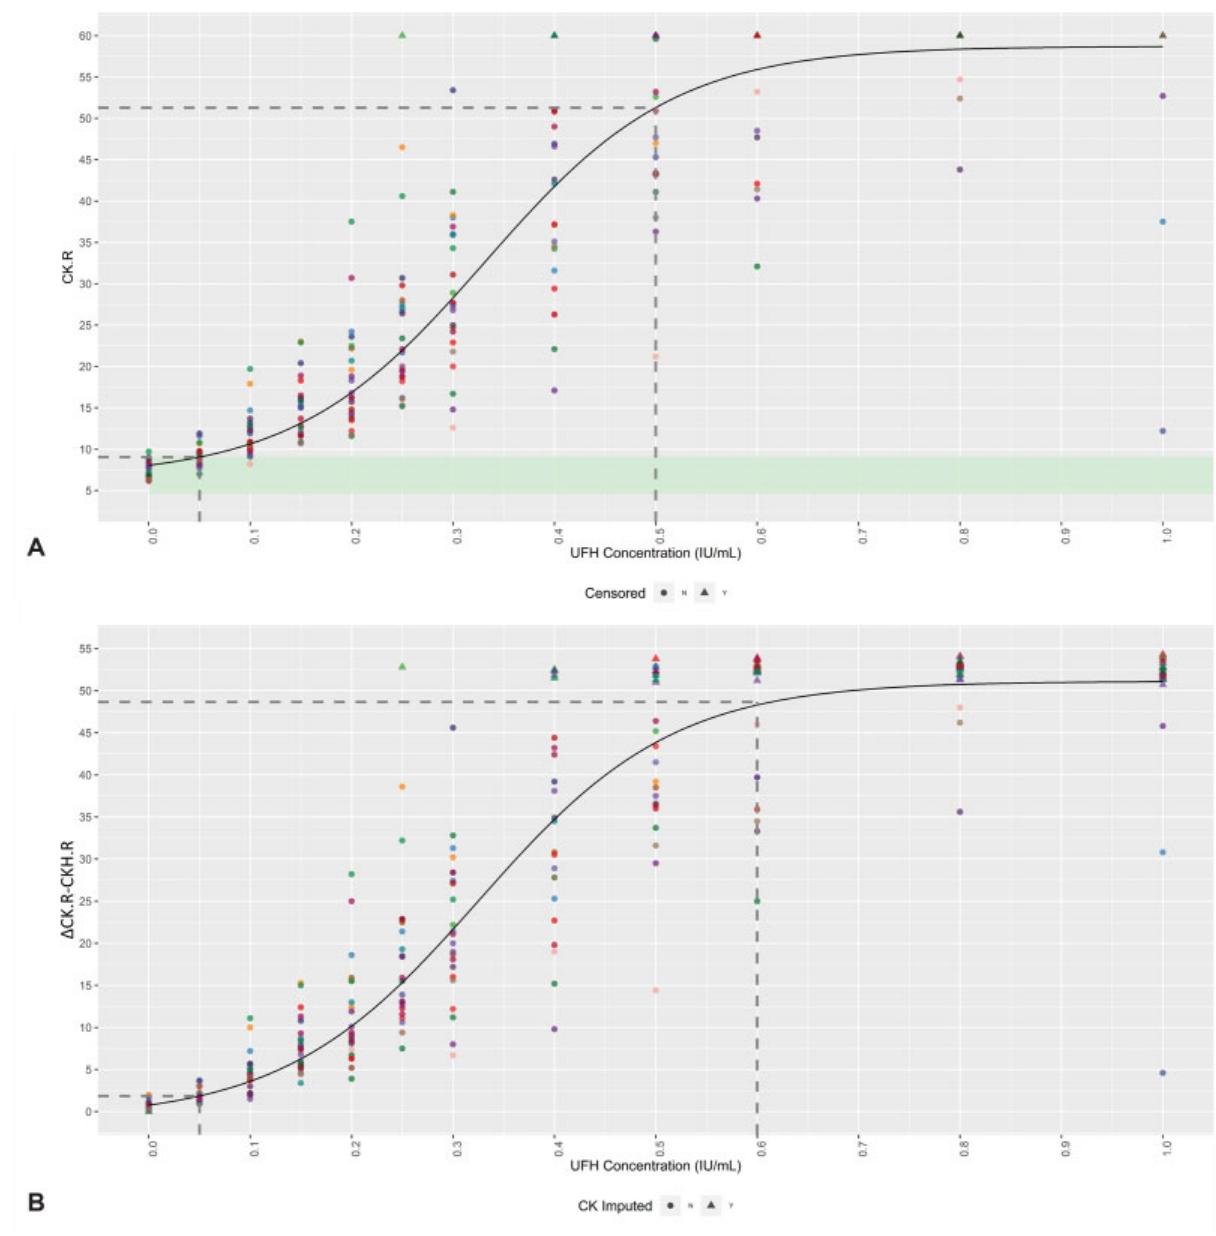
Fig. 1 Concentration-dependent effects of UFH on the TEG 6s parameters. Mixed-effect four-parameter logistic model of ( A ) CK.R, ( B ) Δ CK.R (cid:3) CKH.R, ( C ) ratio CKH.R/CK.R, and ( D ) ratio CK.R/CKH.R in relation to the UFH concentration. Individual donors are highlighted in different colors, with the model ( black line ) included. Reference range limits are shown in light green . The dotted lines represent the minimum and maximum values ( fi rst dose where the response was statistically signi fi cant from the dose 0 response or last dose where the response was statistically different from the lastobserved dose in the model, respectively). Values greater than 60 are beyond the limitofdetection, and so are marked as censored. CK, kaolin; CKH, kaolin with heparinase; R, reaction time; UFH, unfractionated